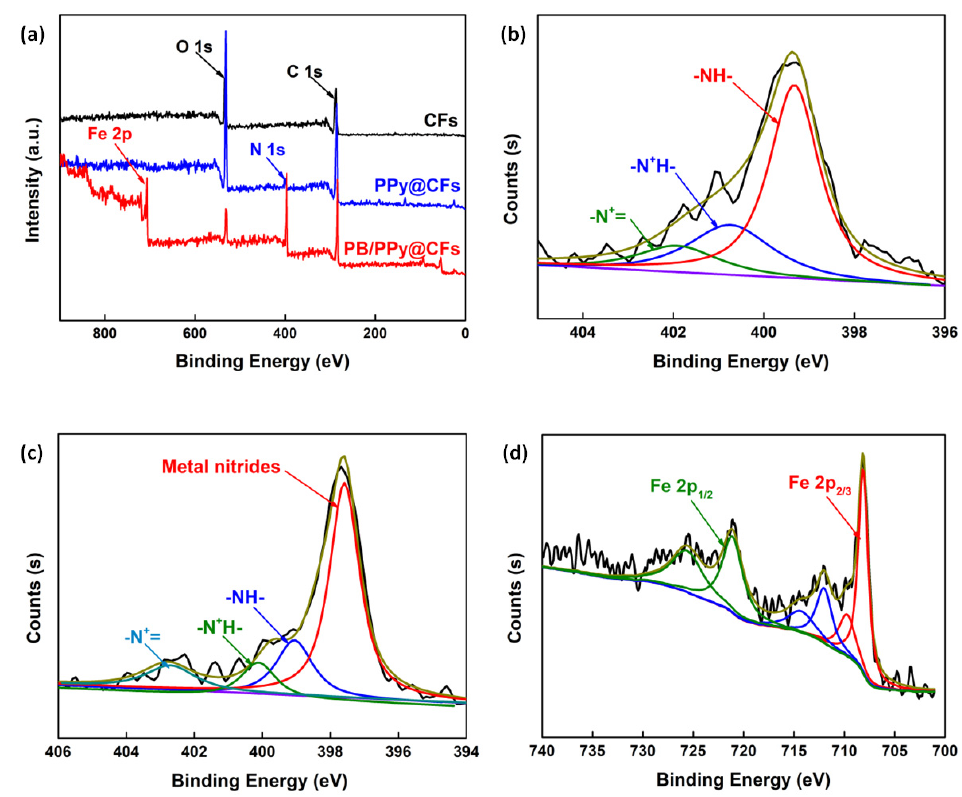
Figure 6. ( a ) XPS wide scan spectra of CFs, PPy@CFs, and PB/PPy@CFs; ( b ) N 1s XPS spectrum of PPy@CFs; N 1s ( c ) and Fe 2p ( d ) XPS spectra of